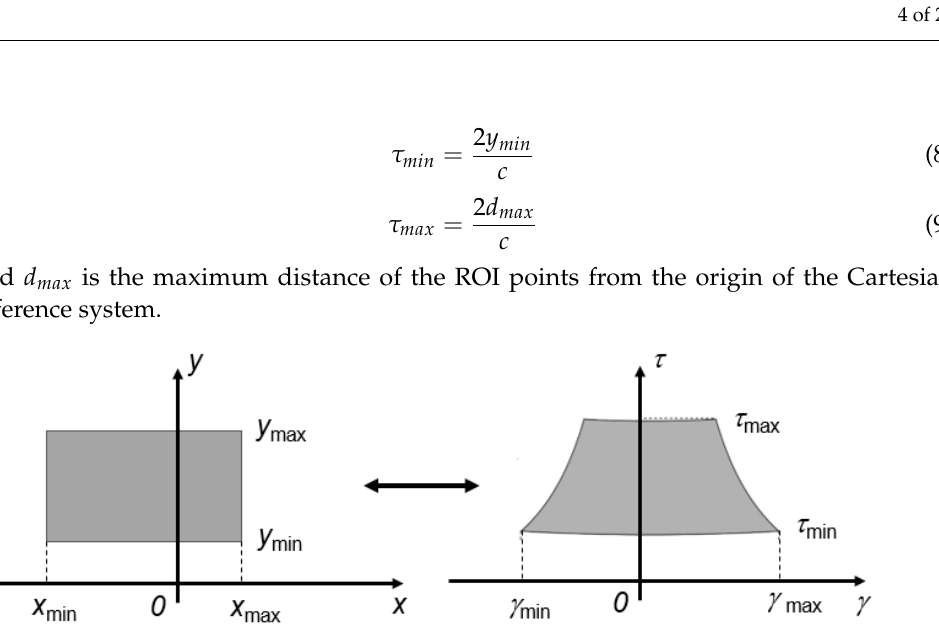
Figure 2. Mapping of the ROI in the corresponding region expressed by means of the 𝛾 and 𝜏 variables.